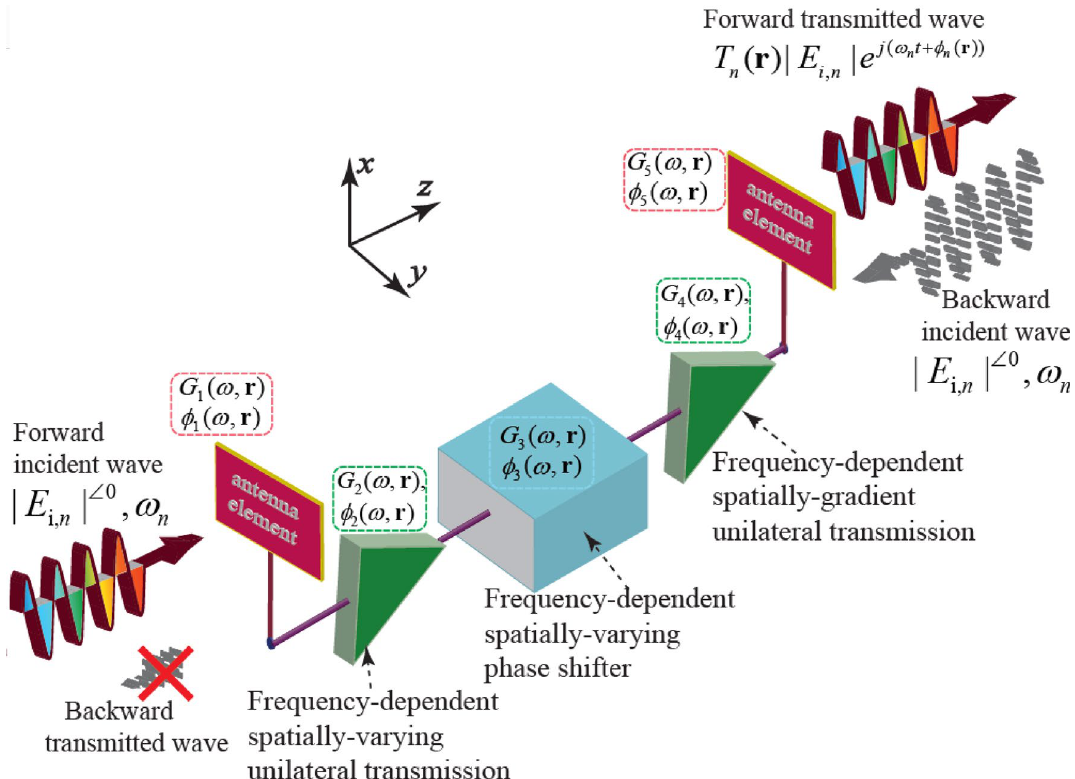
Figure 3. Architecture of a radiating super-cell incorporating frequency-dependent spatially-varying passive and active electronic-electromagnetic elements.